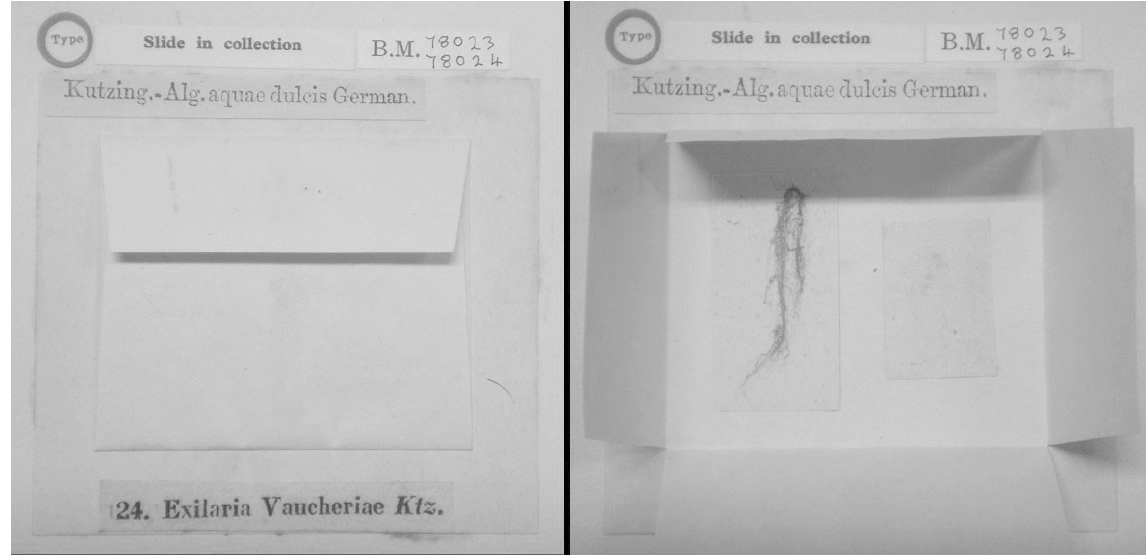
Fig. 2. Type material of Fragilaria vaucheriae deposited in the Natural History Museum of London (BM 78023, BM